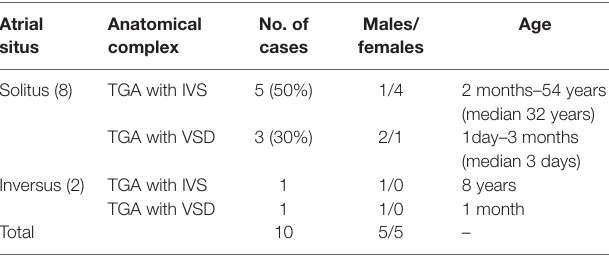
TaBle 8 | corrected Tga.